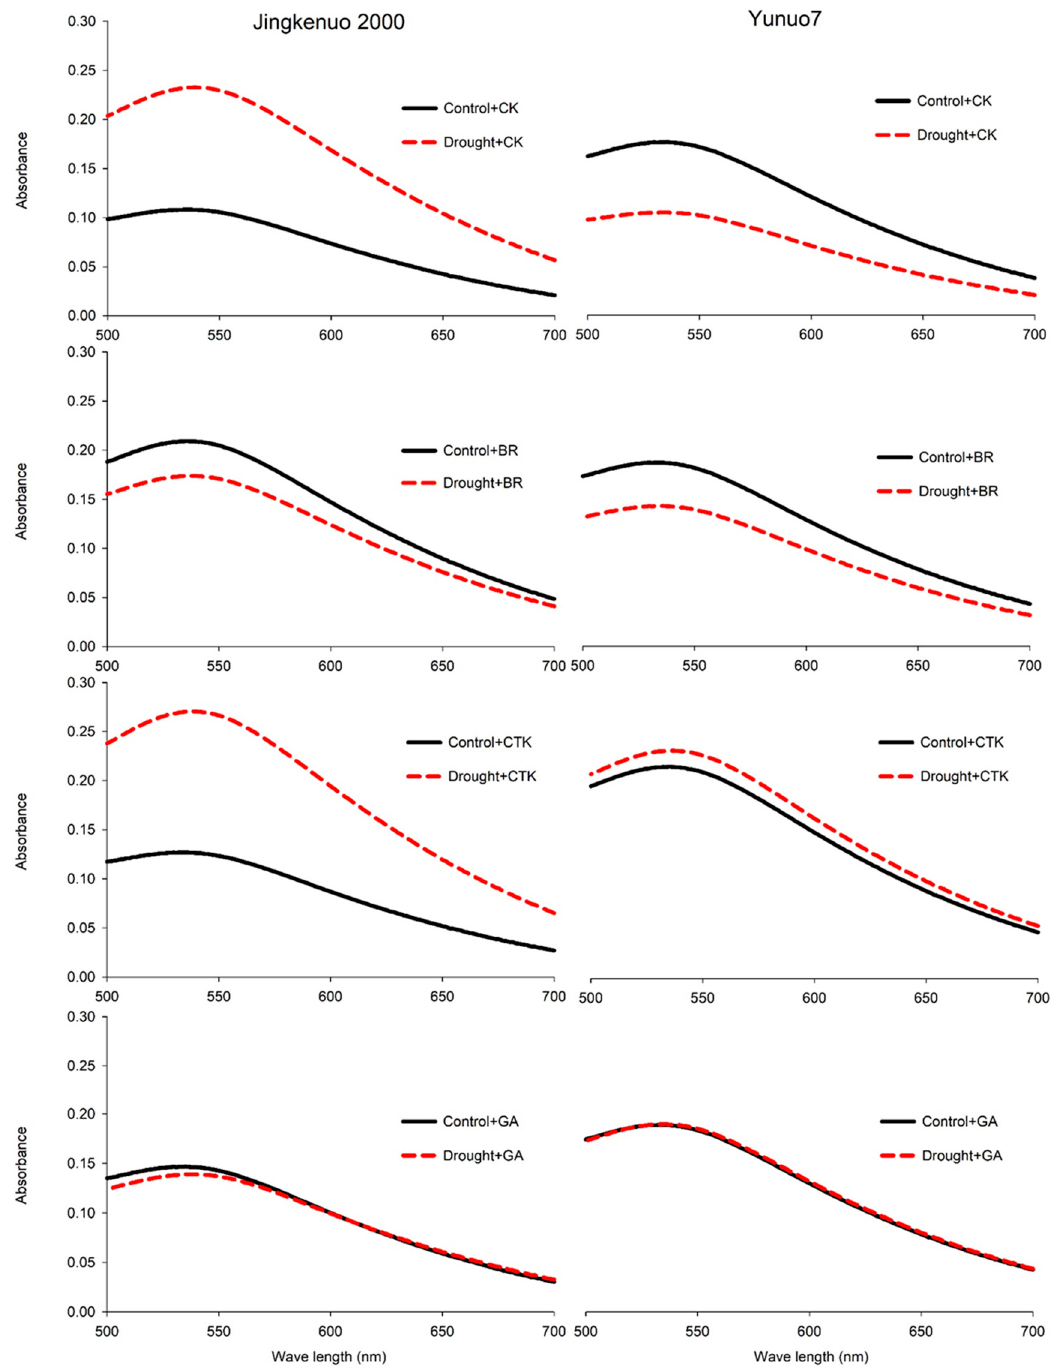
Figure 6. The starch wavelength distributions with exogenous hormones under control and drought conditions in waxy maize. CK, water; CTK, cytokinin; BR, brassinolide; GA, gibberellic acid.